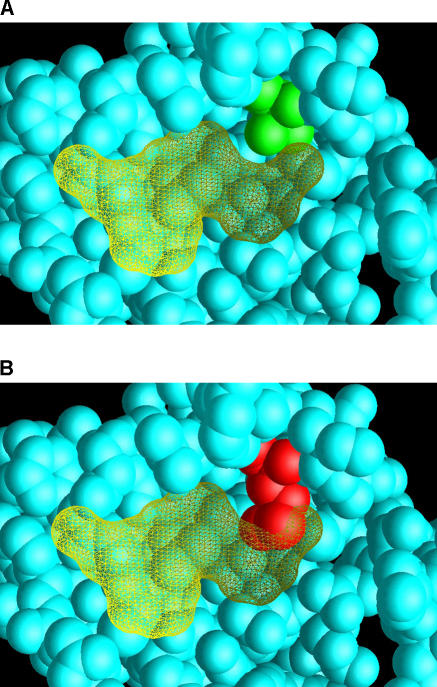
Structural Models of EGFR Showing the T790M Resistance Mutation(A) Space-filling representation of the wild-type kinase active site (cyan) with the viewer looking down the vertical axis. The structure above the plane of the figure is omitted for clarity. The threonine 790 side chain is green, and erlotinib's molecular surface is shown as a yellow net.(B) The threonine 790 side chain is replaced by the corresponding methionine side chain from the structure of the insulin receptor tyrosine kinase (Protein Data Bank entry 1IRK). The EGFR and insulin receptor have a similar structure in this region of the active site. The methionine side chain would sterically clash with erlotinib, as shown, as well as with the related kinase inhibitor gefitinib (not shown).(Figure: Nikola Pavletich, Structural Biology Program, Memorial Sloan-Kettering Cancer Center)